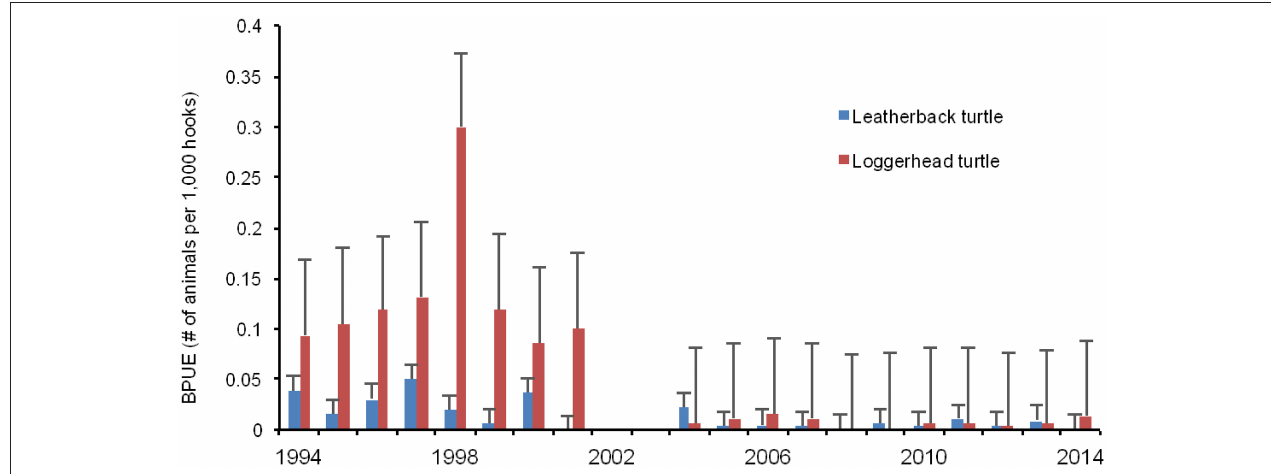
FIGURE 4 | Leatherback and loggerhead BPUE (# individuals caught per 1,000 hooks, ± SD) for Hawaii-permitted shallow set longline fishery by year.